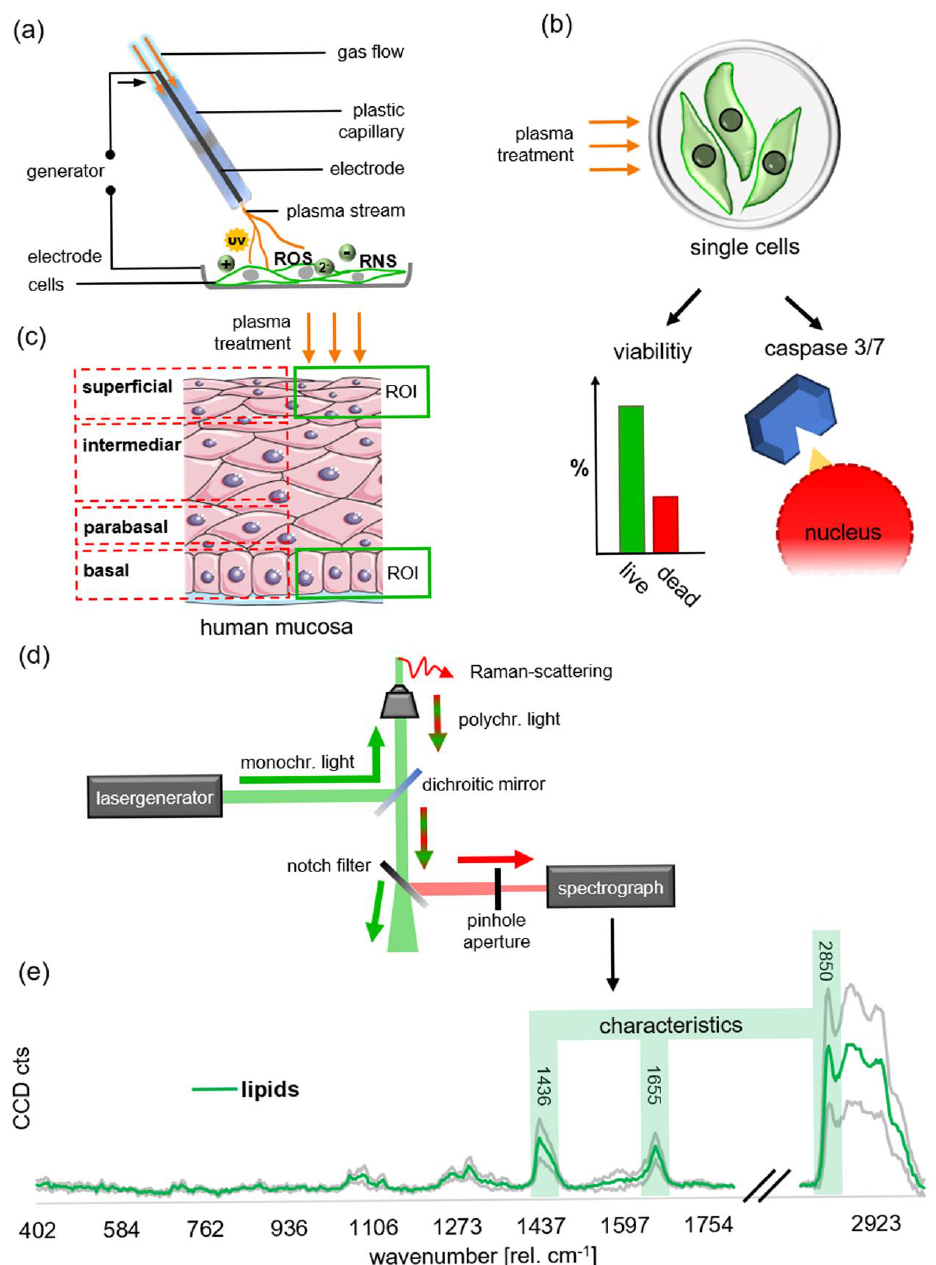
Figure 3. Schematic illustration of the experimental setup. ( a ) Setup of superficial tissue treatment with NIPP, utilizing the Vio3/APC3 (Erbe Elektromedizin); ( b ) CC single cell analysis via live/dead staining and Caspase3/7 assays; ( c ) Structure of stratified squamous epithelium in cervical tissue, modified based on https: // creativecommons.org / licenses / by / 3.0 / deed.de. Green boxes designate the investigated regions of interest (ROI); ( d ) Schematic of the Raman microscope. ( e ) Representative Raman spectrum from untreated cervical control tissue. Wavelengths highlighted with green bars represent the characteristic composition of bands (at 1436, 1657, and the main band at 2850 rel. cm − 1 ) utilized in this study to identify specifically lipid components out of the multiple Raman spectra obtained by Raman imaging, representing various biomolecules